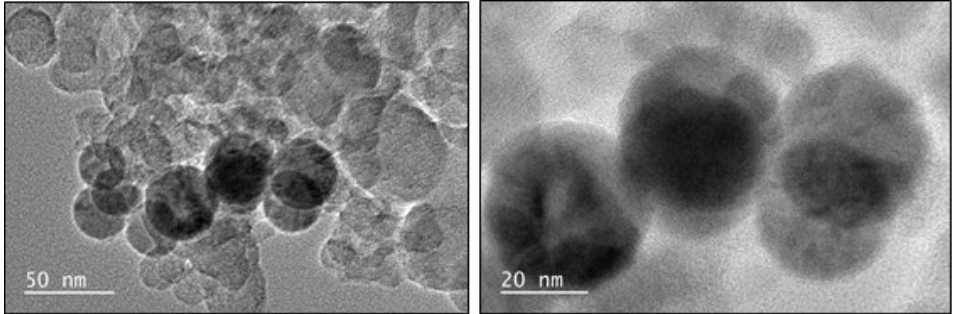
Figure 4. TEM image of THP-1 derived exosomes.